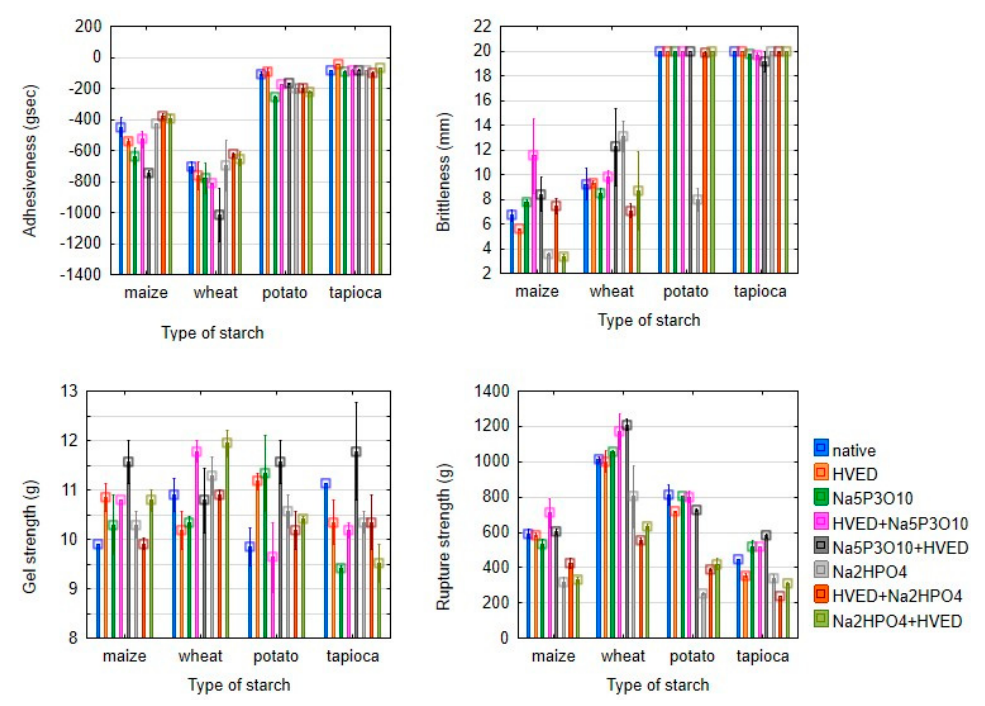
Figure 4. Gel texture properties (mean ± 2SD) of starches modified with high-voltage electrical discharge and phosphorylation.